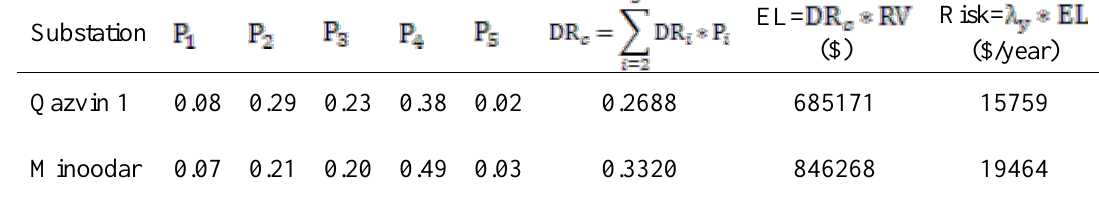
Table 14. The evaluation of economic loss and existing risk for the Qazvin power substations